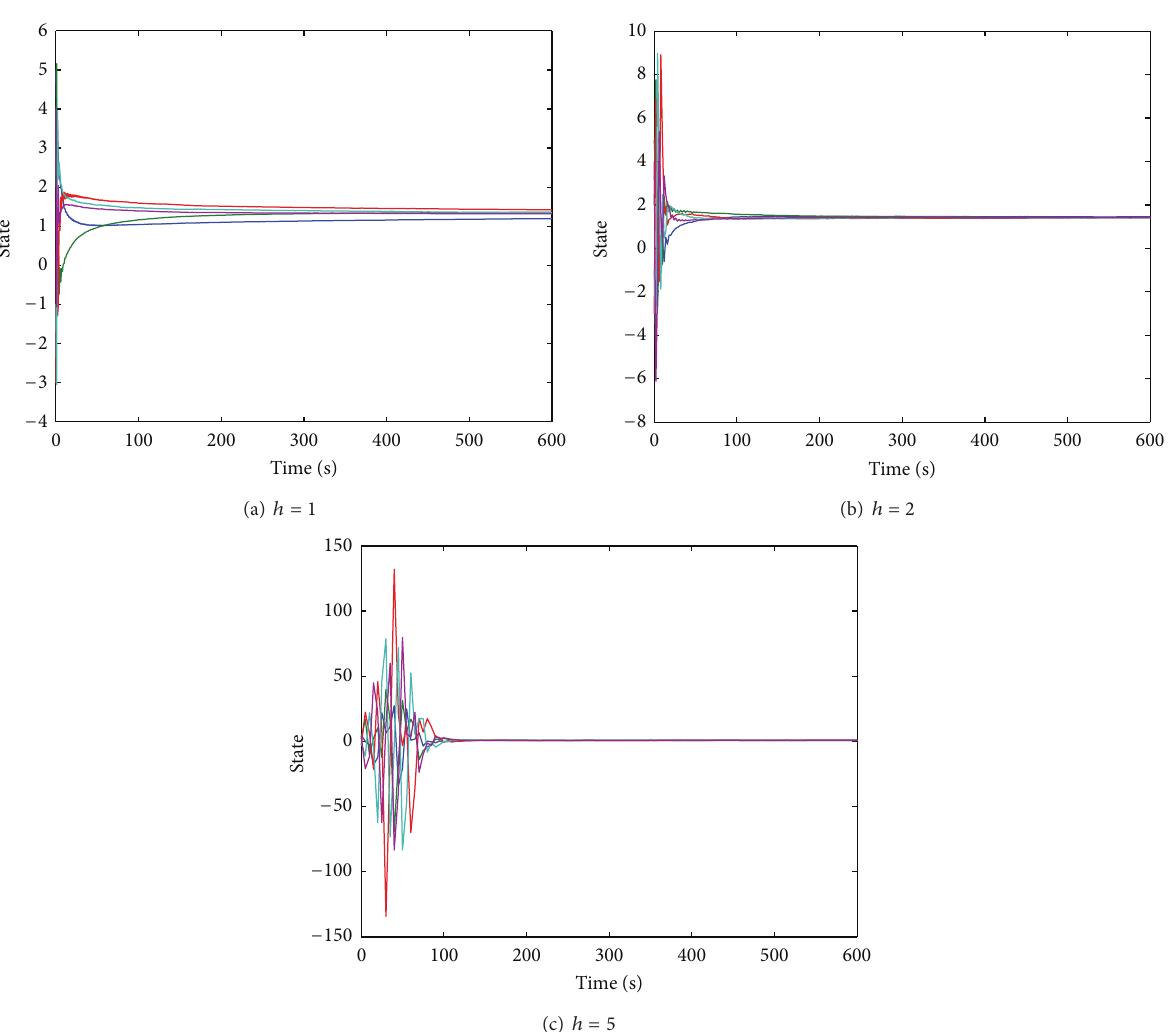
constant under different sampling periods with